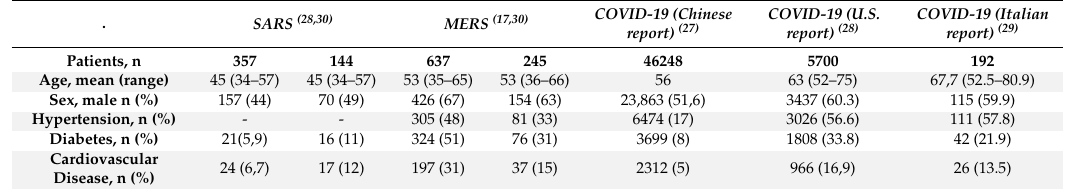
Table 1. Comparison between cardiological clinical features of SARS, MERS and COVID-19.